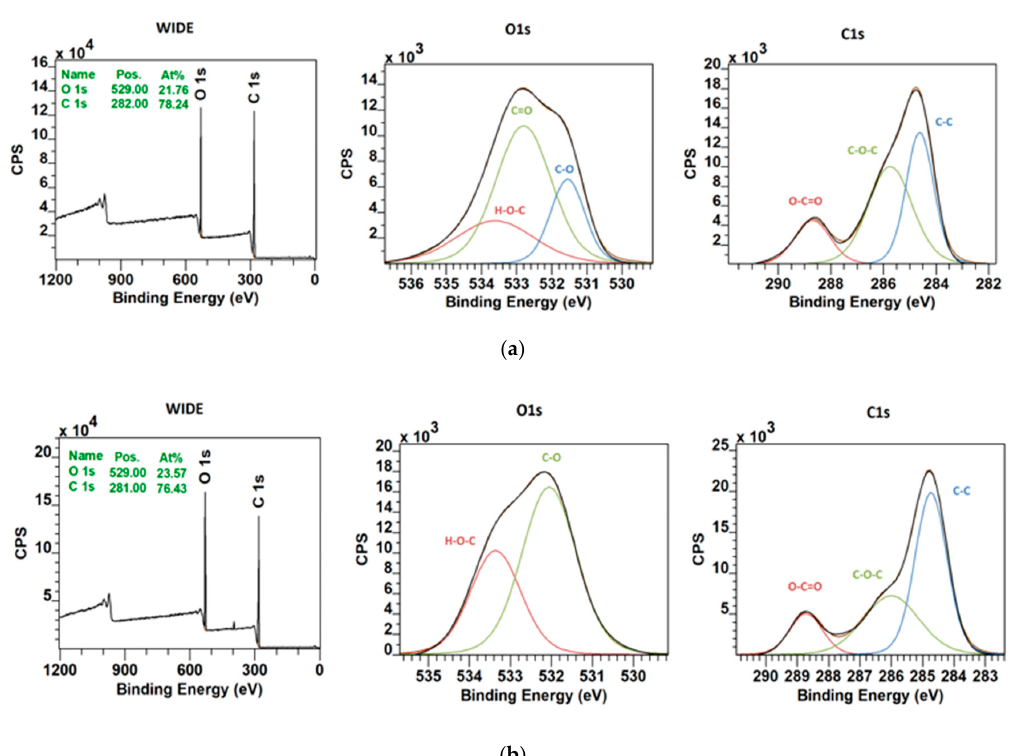
Figure 6. XPS analysis of the sample PCL-2 ( a ) before and ( b ) after the plasma treatment.